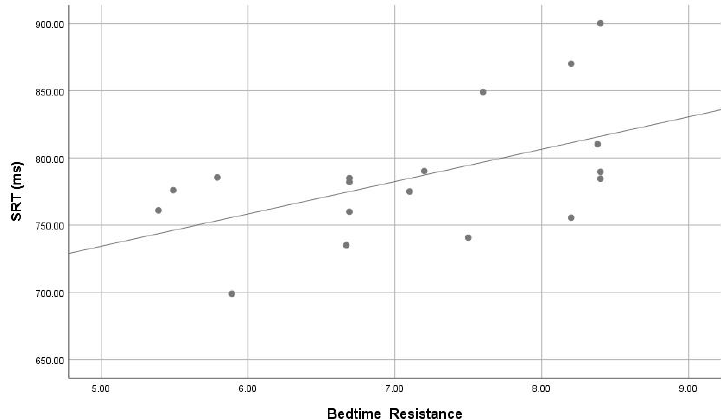
Figure 2. The positive correlation (r = 0.531, p = 0.023) of bedtime resistance (CSHQ subscale) and simple reaction time (ms) in ASD.